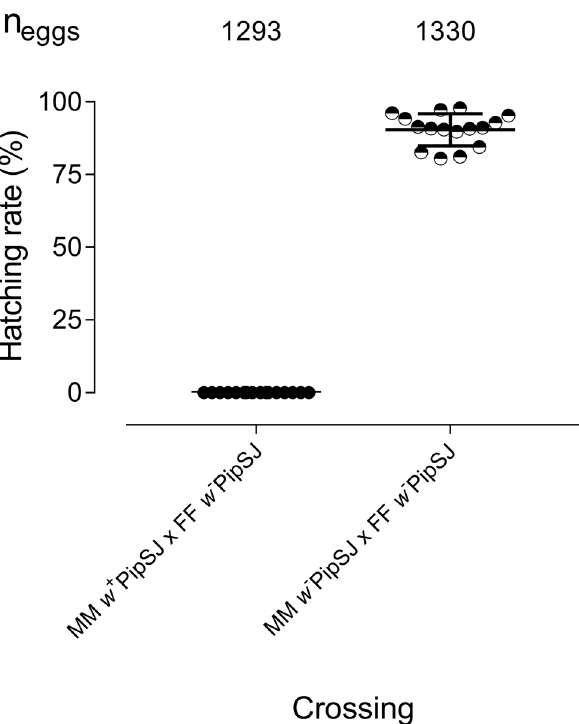
Figure 4. Complete unidirectional cytoplasmic incompatibility in Culex quinquefasciatus lines. Egg hatching percentage in crosses between the wild type ( w + PipSJ) and tetracycline-treated ( w − PipSJ) strains of Cx. quinquefasciatus . Sixteen couples were used in each type of crossing. Each dot represents a mosquito egg raft from a unique female, carrying approximately 150 eggs per raft. The median number of hatched eggs/egg-raft are shown in horizontal